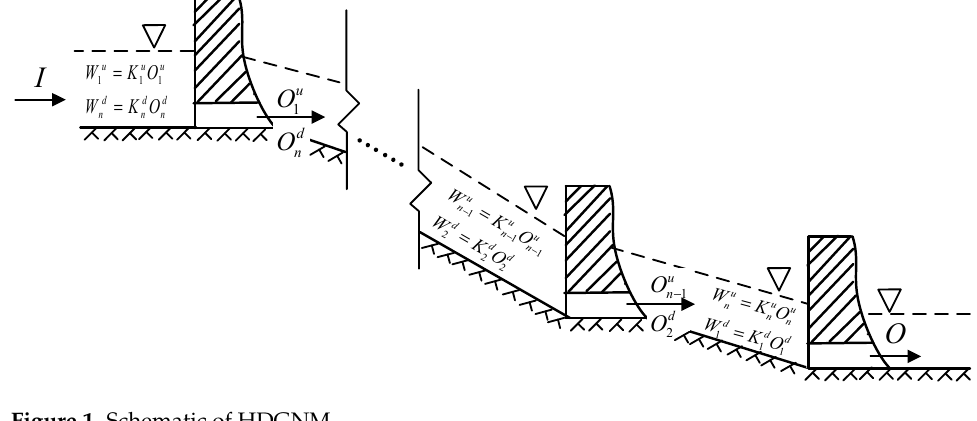
Figure 1. Schematic of HDGNM.